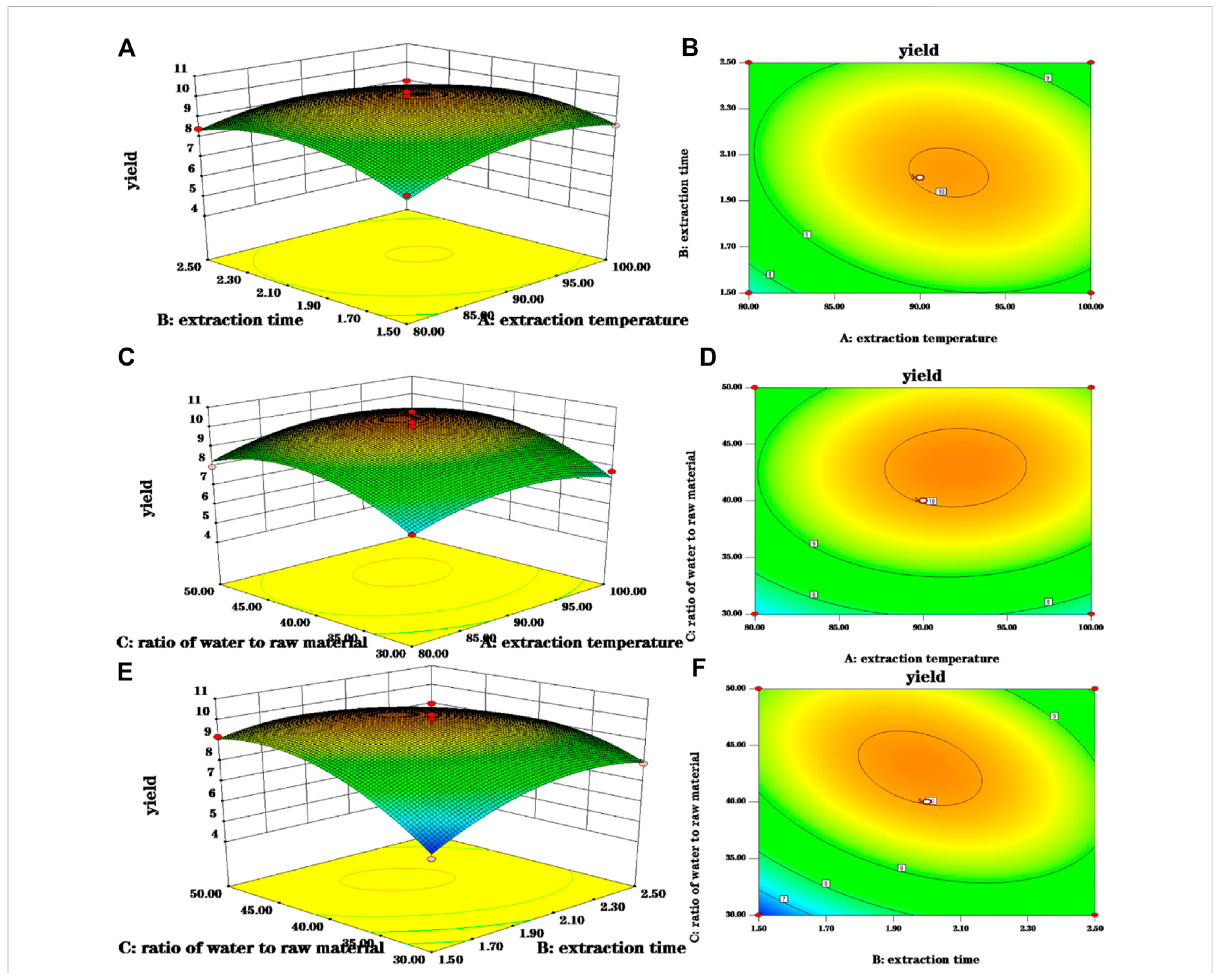
FIGURE 3 3-D response surface and 2-D contour plots for polsaccharides yield. (A,B) Were 3-D response surface and 2-D contour plots showing the interaction of extraction time and extraction temperature on the yield of polysaccharides; (C,D) were 3-D response surface and 2-D contour plots showingtheinteractionofratioofwatertorawmaterialandextractiontimeontheyieldofpolysaccharides; (E,F) were3-Dresponsesurfaceand2-D contour plots showing the interaction of ratio of water to raw material and extraction time on the yield of